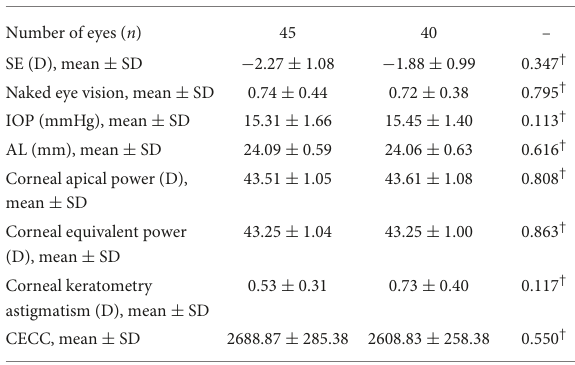
TABLE 1 Demographic data and clinical characteristics of the patients. OK group